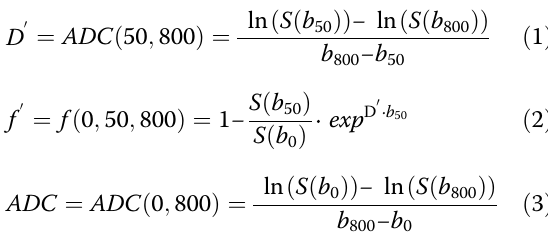
Table. 2 Technical parameters of the diffusion-weighted imaging (DWI) sequence Name Field of view (right-left × anterior-posterior)/orientation